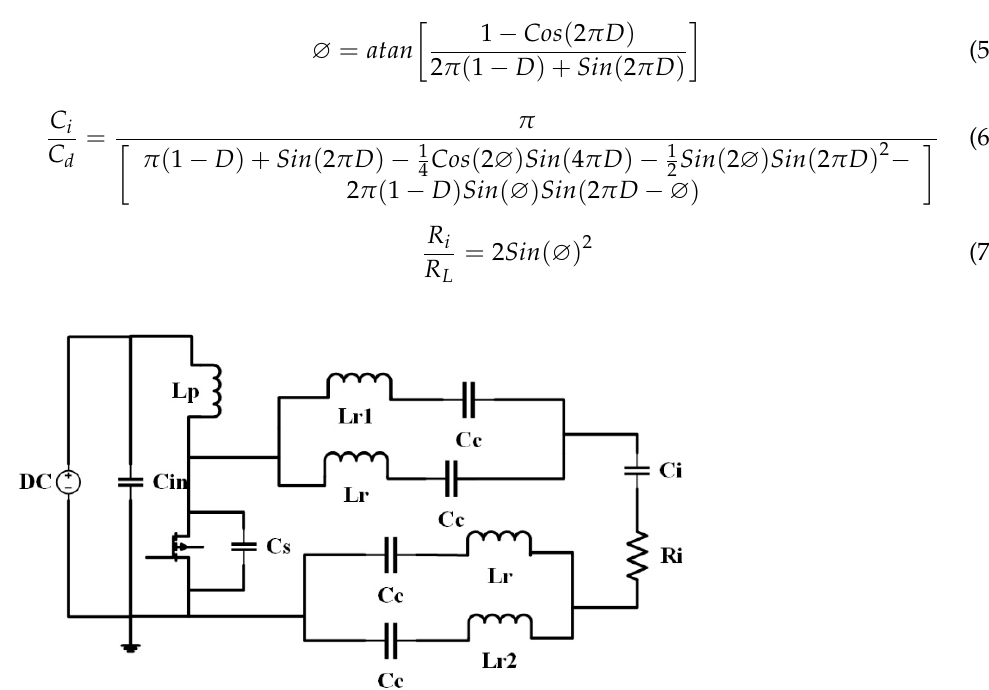
Figure 4. Equivalent rectifier circuit of class-E 2 converter with 8-plate multi-resonant coupling.